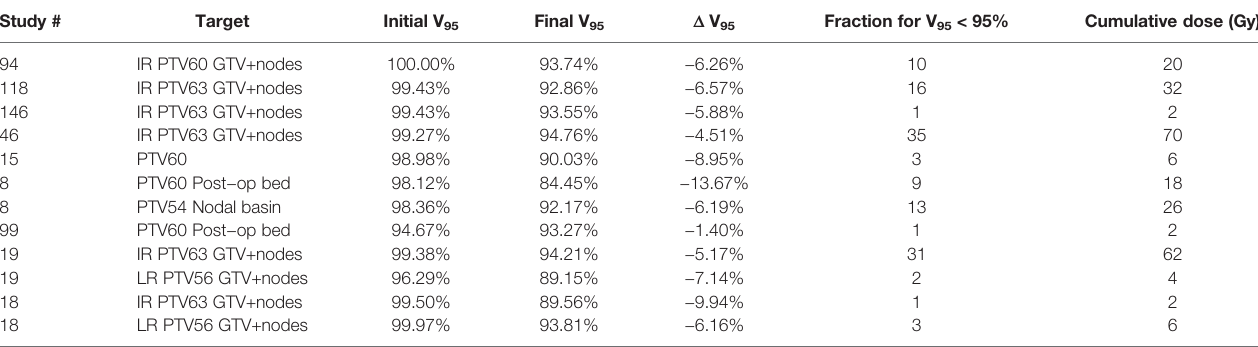
TABLE 4 | PTV coverage for patient studies with V 95 < 95% coverage at end of